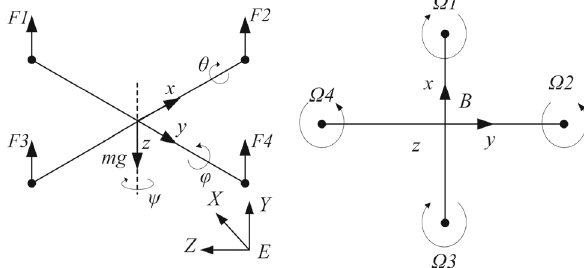
Fig. 6 Force model of UAV